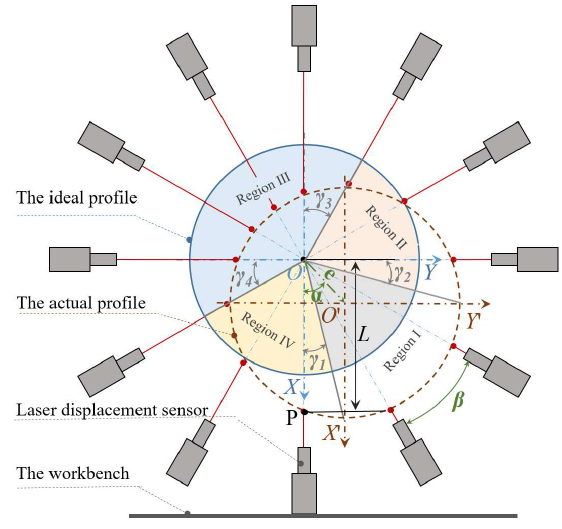
Figure 1. Schematic diagram of the reversal method. To evaluate the error caused by sampling unevenness, the actual contour is divided into four quadrants according to the coordinate axes, and the total number of samples of the actual contour is defined as N. The number of samples of the arc segments in the four quadrants corresponding to the actual contour is n 1 , n 2 , n 3 , and n 4 . Additionally, the maximum of n 1 , n 2 , n 3 , and n 4 is defined as as n max , and the minimum as n min . The ratio ε between n max and n min is the evaluation of sampling uniformity, as shown in Equation (2). If ε is close to 1, it indicates that the sampling uniformity is better.